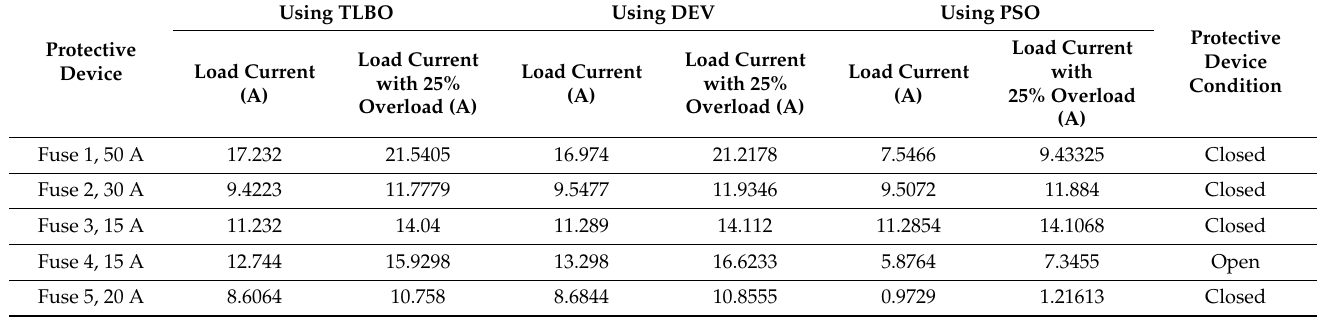
Table 2. Protective device condition in optimal configuration without protection constraints.